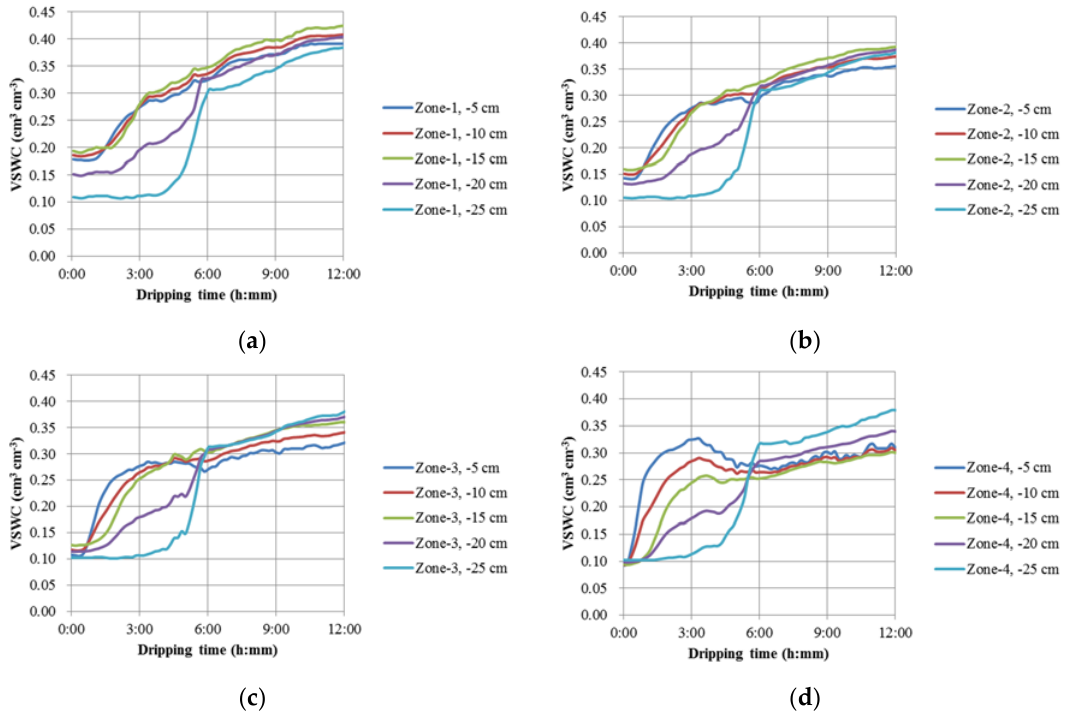
Figure 6. Temporal variations of the soil water content along the four tubes (Z ‐ Axis) (( a ) Zone ‐ 1, ( b ) Zone ‐ 2, ( c ) Zone ‐ 3 and ( d ) Zone ‐ 4) under single ‐ drip irrigation condition.